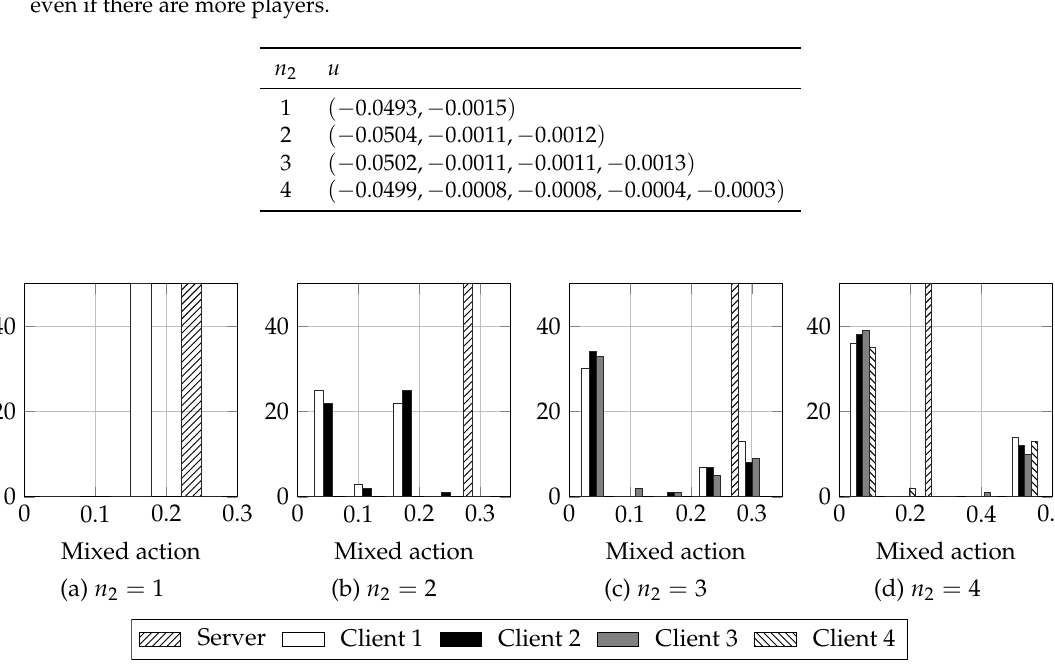
Table 4. Empirical payoffs obtained using RM for each value of n 2 . The payoff vector u has the server payoff first and then, the payoff of each client. Observe that payoffs do not significantly vary as the number of players increase. This is consistent with Figure 4: the game tends to the two player situation, even if there are more players.